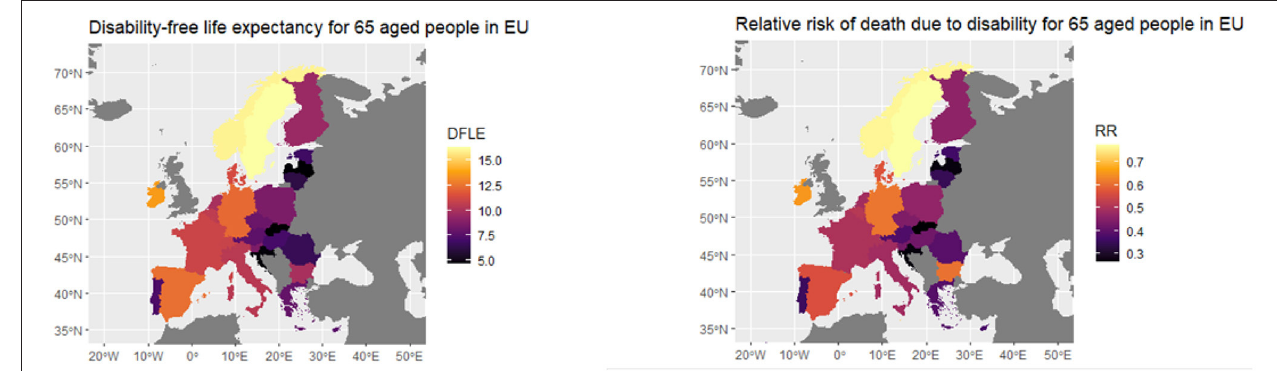
FIGURE 8 | Disability-free survival probability and relative risk for 65yo in EU.